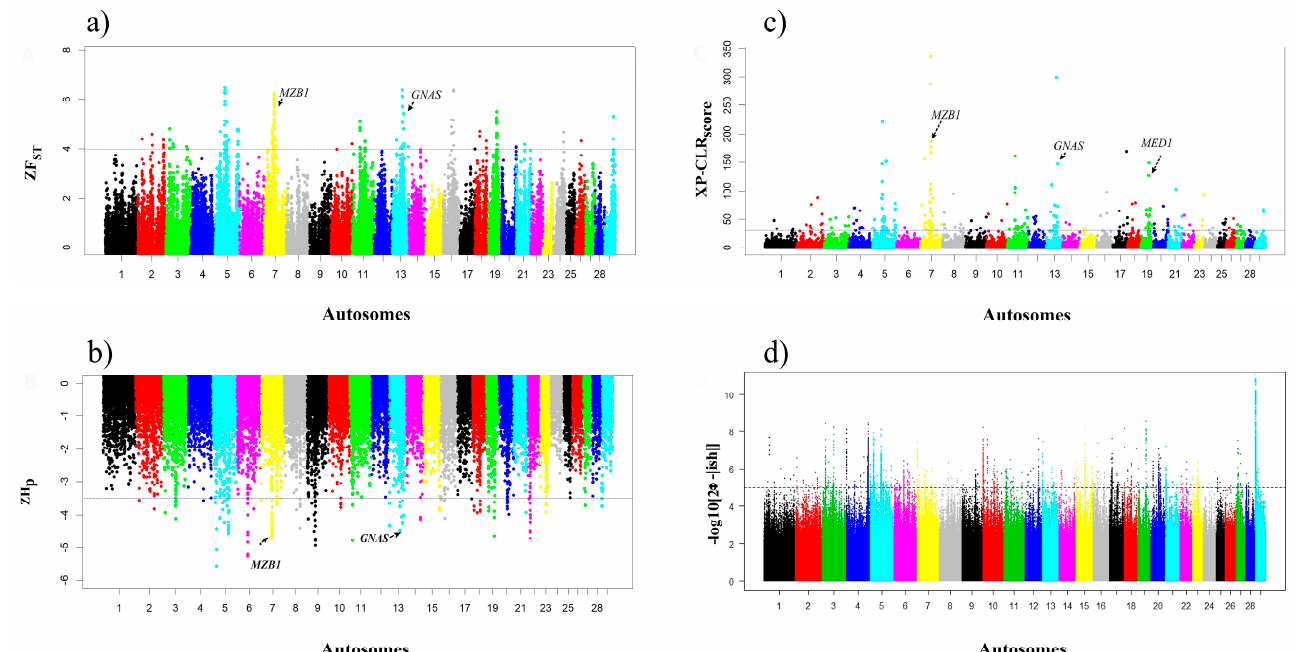
Figure 7. Manhattan plot of genome scan results. The dashed line is the threshold line that shows the top 0.5% significant genomic regions. ( a ) Population differentiation ( F ST ) at a threshold of ZF ST = 4, ( b ) pooled heterozygosity at a threshold of ZHp = − 3.5, ( c ) XP-CLR at a threshold of XP-CLR score = 10, and ( d ) iHS at a threshold of − log10[ Φ − |iHS|] = 5.